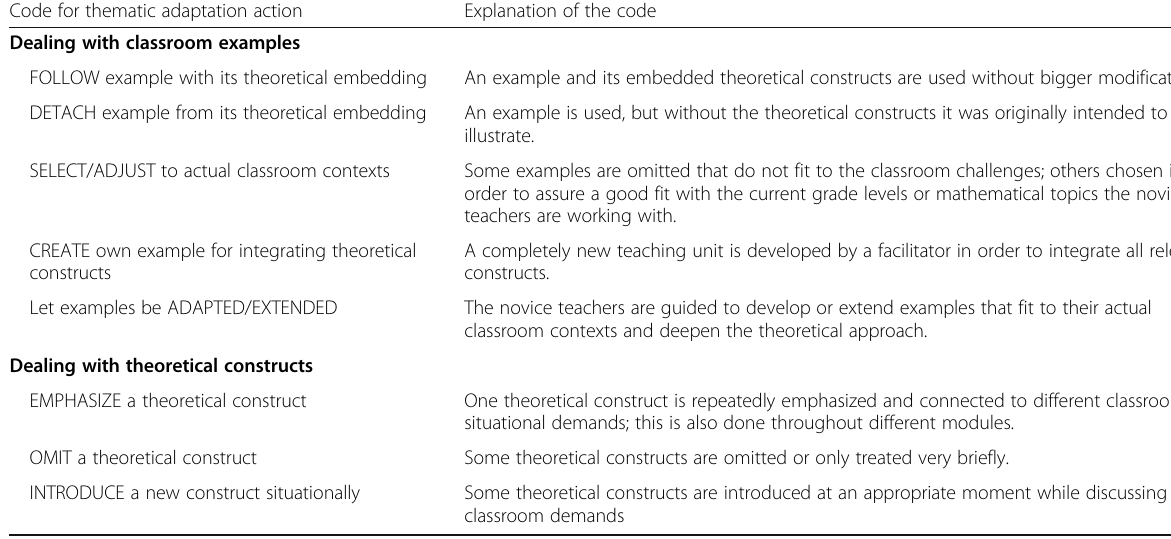
Table 2 Expert facilitators ’ thematic adaptation actions: descriptive results of the category formation process Code for thematic adaptation